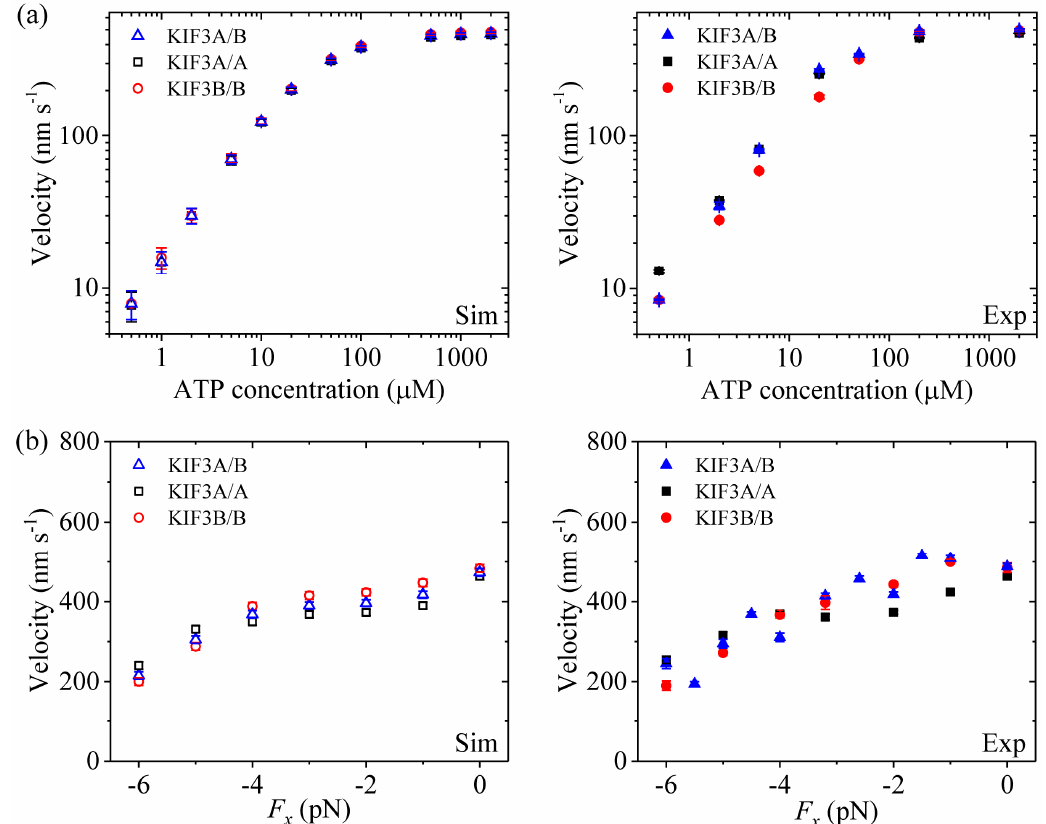
Figure 3. Kinesin-2 velocity as a function of [ATP] and force. Left panels show simulated data, while right panels show experimental data taken from Andreasson et al. [8]. ( a ) KIF3A / B, KIF3A / A and KIF3B / B velocity versus [ATP] at F x = 0. ( b ) KIF3A / B, KIF3A / A and KIF3B / B velocity versus F x at [ATP] = 2 mM.